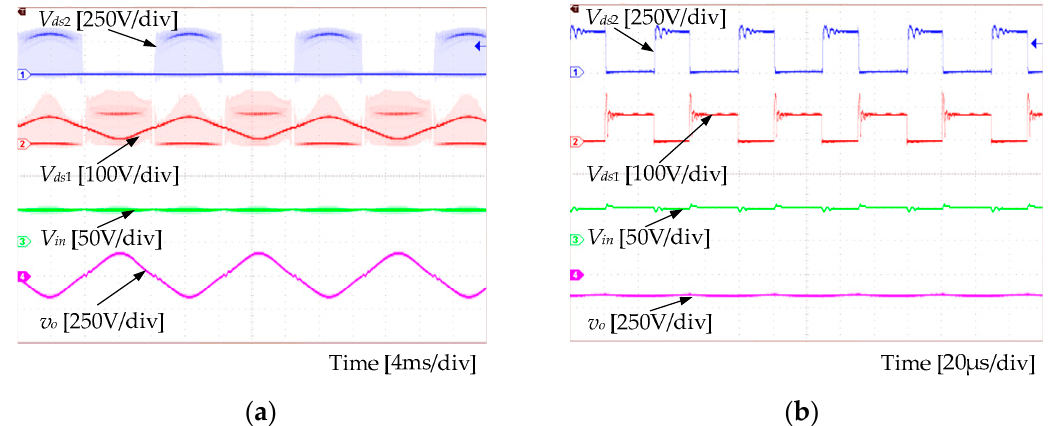
Figure 12. Experimental waveforms of V ds 2 , V ds 1 , V in , and v o : ( a ) At the line period scale, ( b ) at the switching period scale.